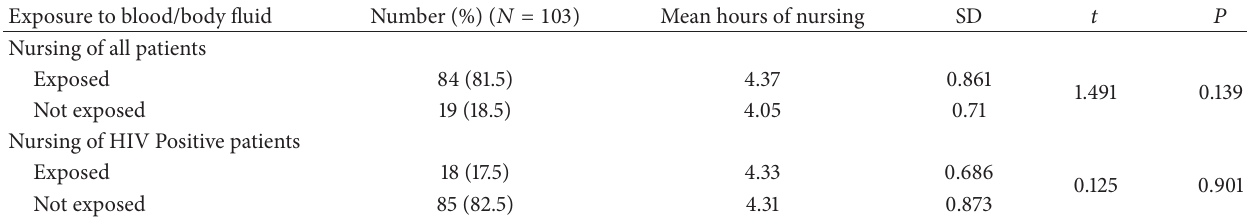
Table 3: Exposure to blood/body fluid among nursing students according to hours of